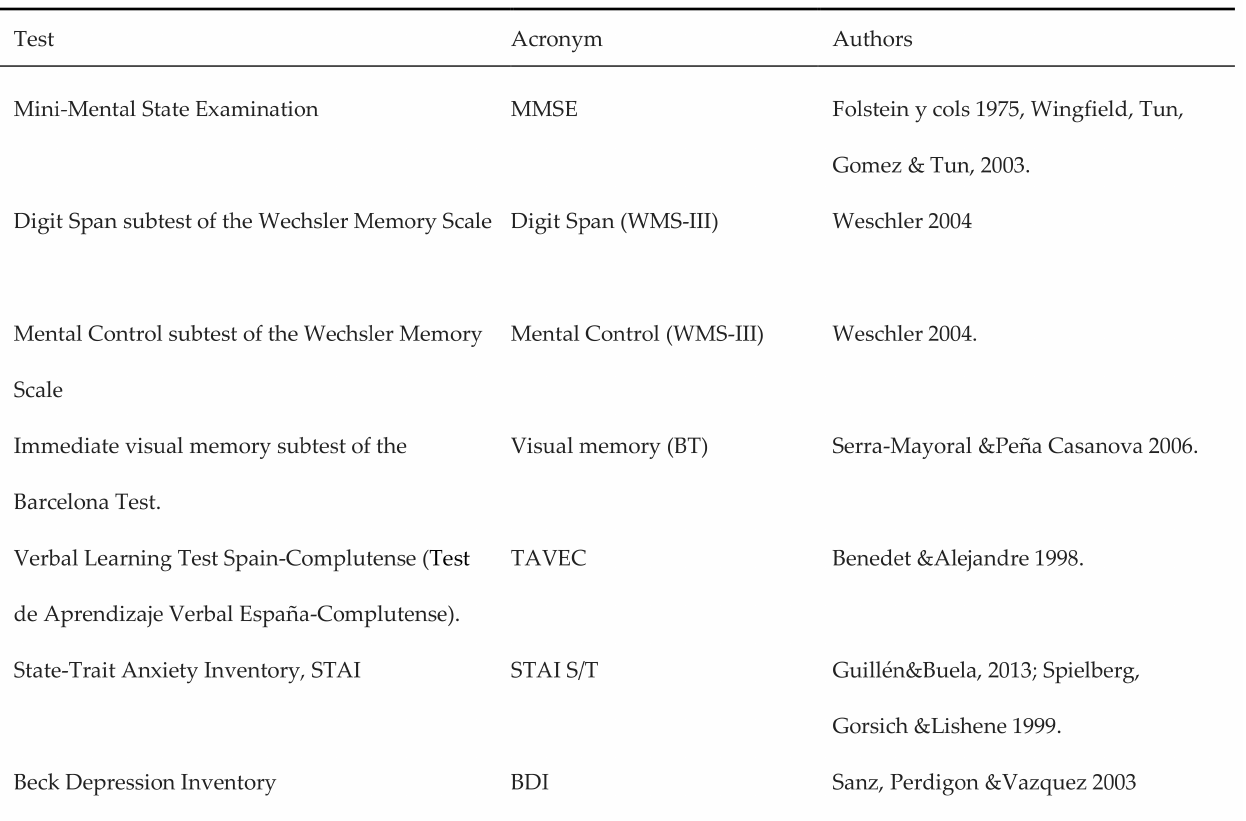
Figure 1. Tests used in the neuropsychological assessment protocol in patients with spinal cord injury. Source: Own elaboration of the